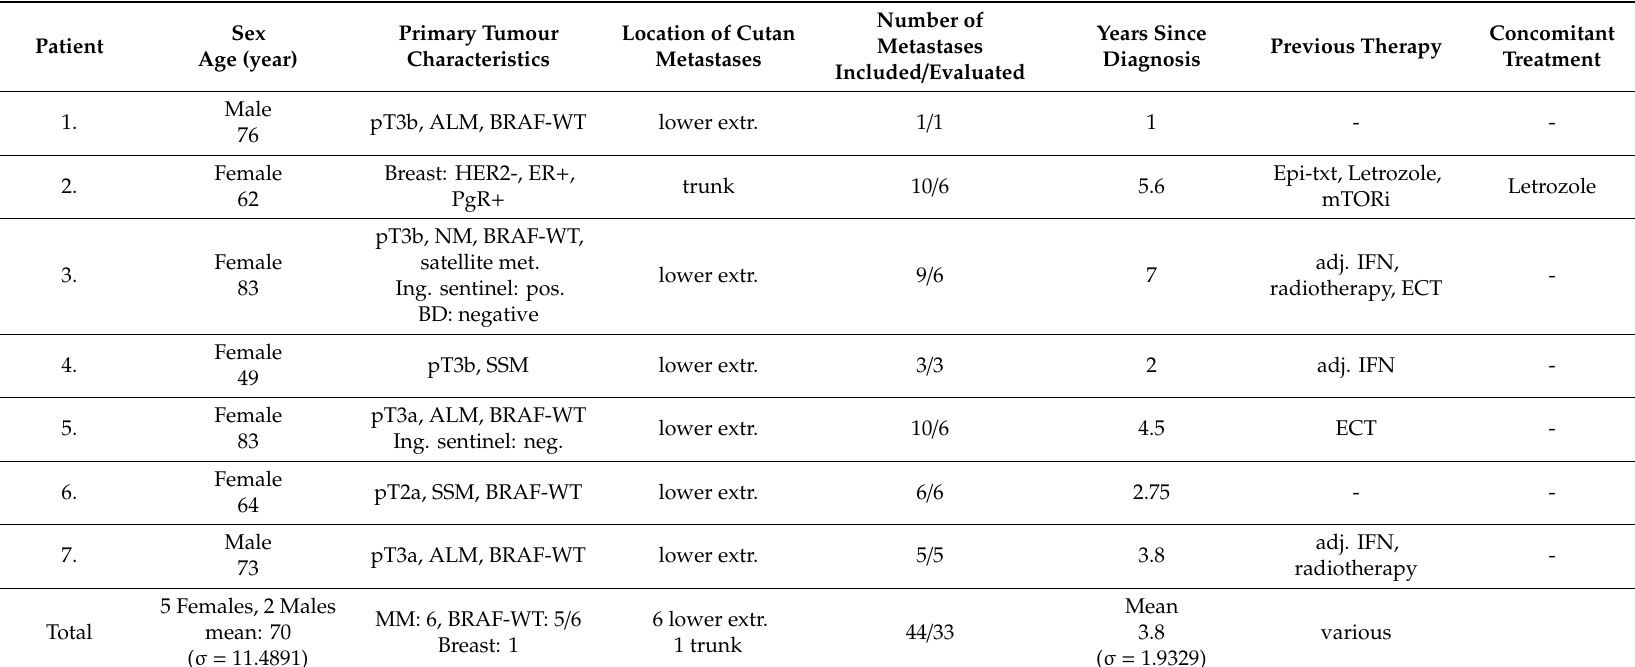
Table 1. Baseline demographic and clinical characteristics of the